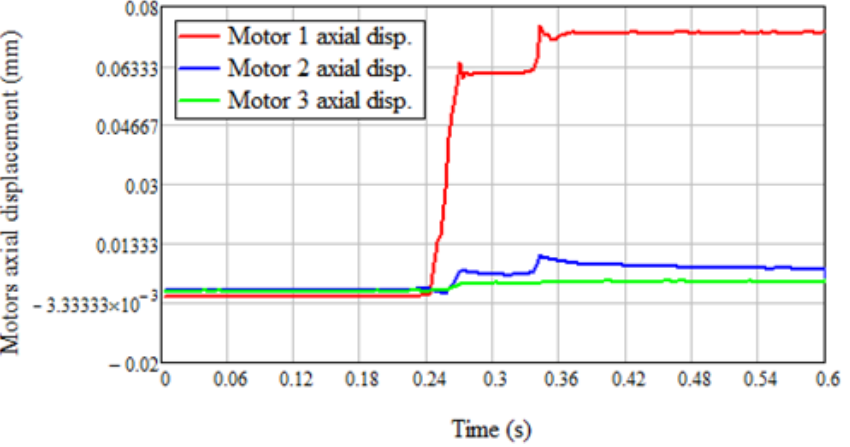
Figure 24. Vertical displacement variations for the 5 kg mass. The average values of the displace- ments were calculated in the time interval (0.72, 0.8) s.